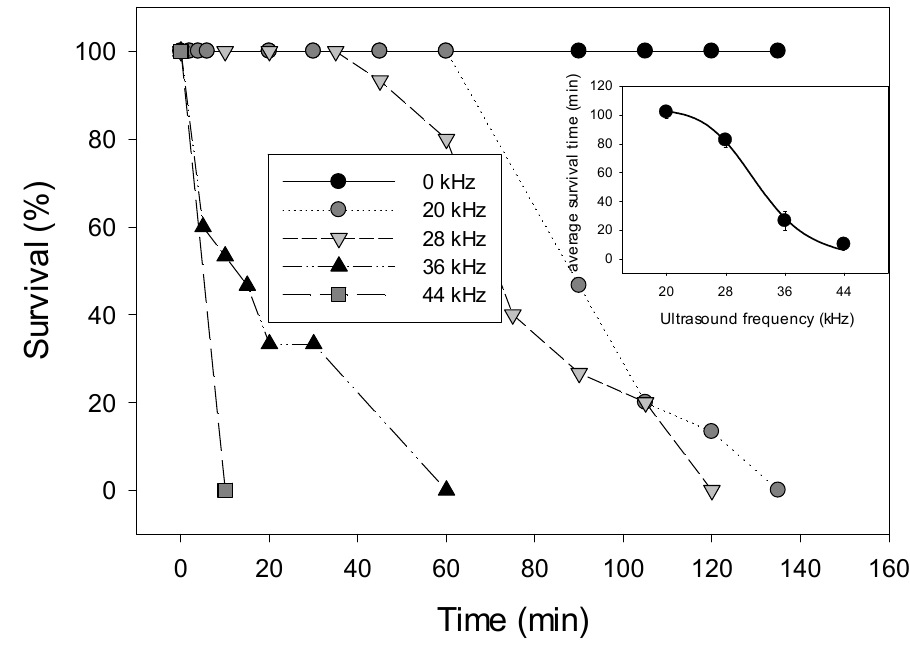
Figure 1. Survival (%) of Daphnia magna in populations not-exposed to ultrasound (0 kHz; controls) and in populations exposed to ultrasound varying in frequency (20, 28, 36 and 44 kHz). The inserted graph gives the mean survival time (min) for Daphnia exposed to each frequency as determined with Kaplan-Meier Survival Analysis (error bars indicate the standard error derived from the Kaplan-Meier Survival Analysis).